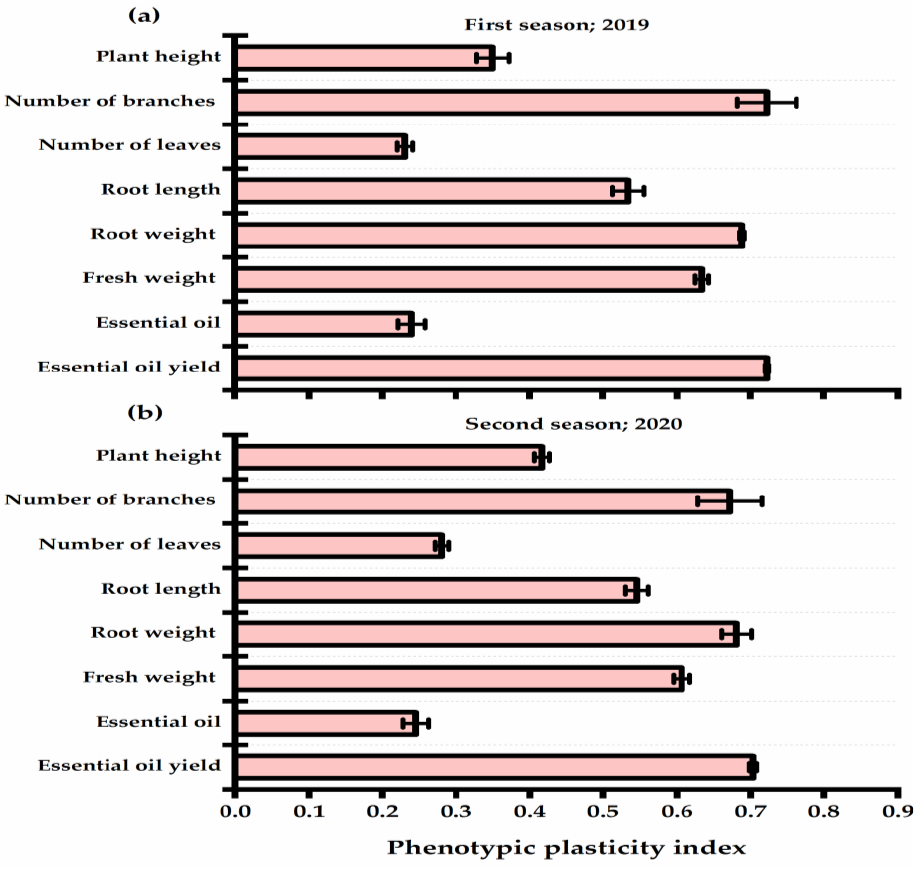
Figure 4. Phenotypic plasticity index of Plectranthus amboinicus (Lour.) Spreng. traits as affected by Rhodotorula muciligenese (Y1), Candida sake (Y2), Candida apicola (Y3), and Candida kunwiensis (Y4) yeast strains foliar application at 0 (C1), 1 × 10 4 (C2), 1 × 10 7 (C3), and 1 × 10 9 (C4) CFU mL −1 concentrations during 2019 ( a ) and 2020 ( b ) seasons. Data are mean value ± SE.